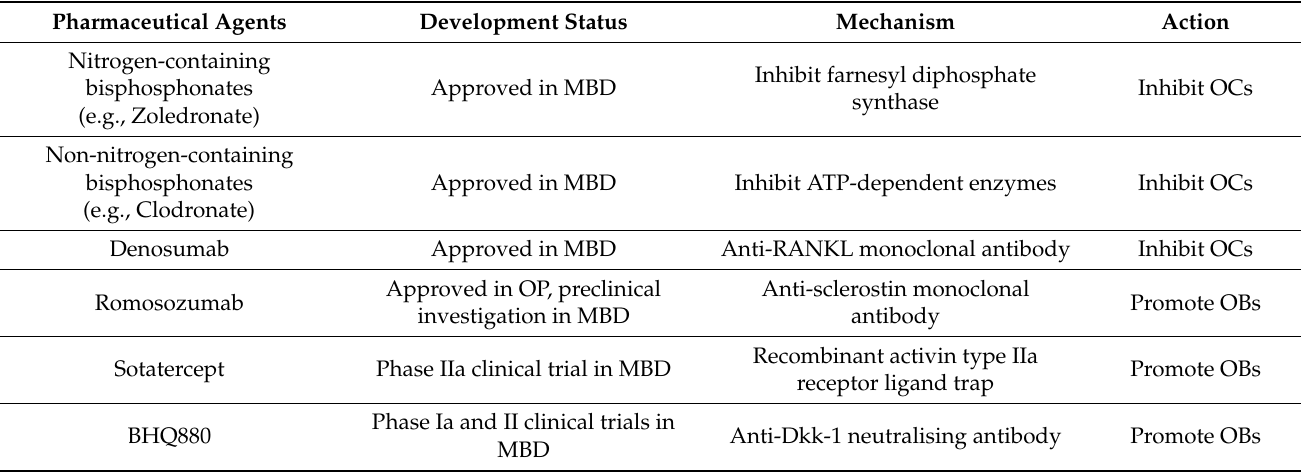
Table 2. Summary of approved treatments for myeloma bone disease and investigational drugs in clinical trials. Pharmaceutical